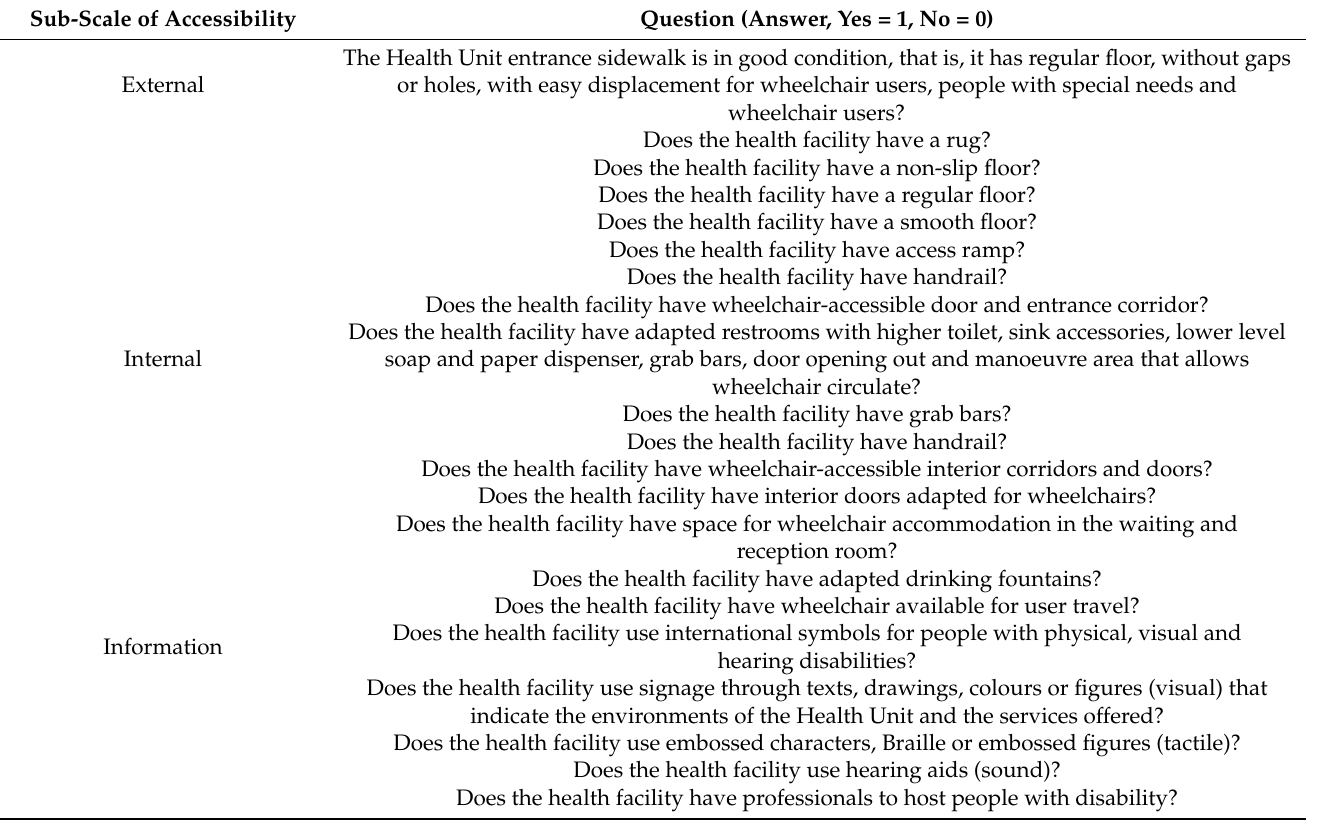
Table 1. Assessment criteria in accessibility